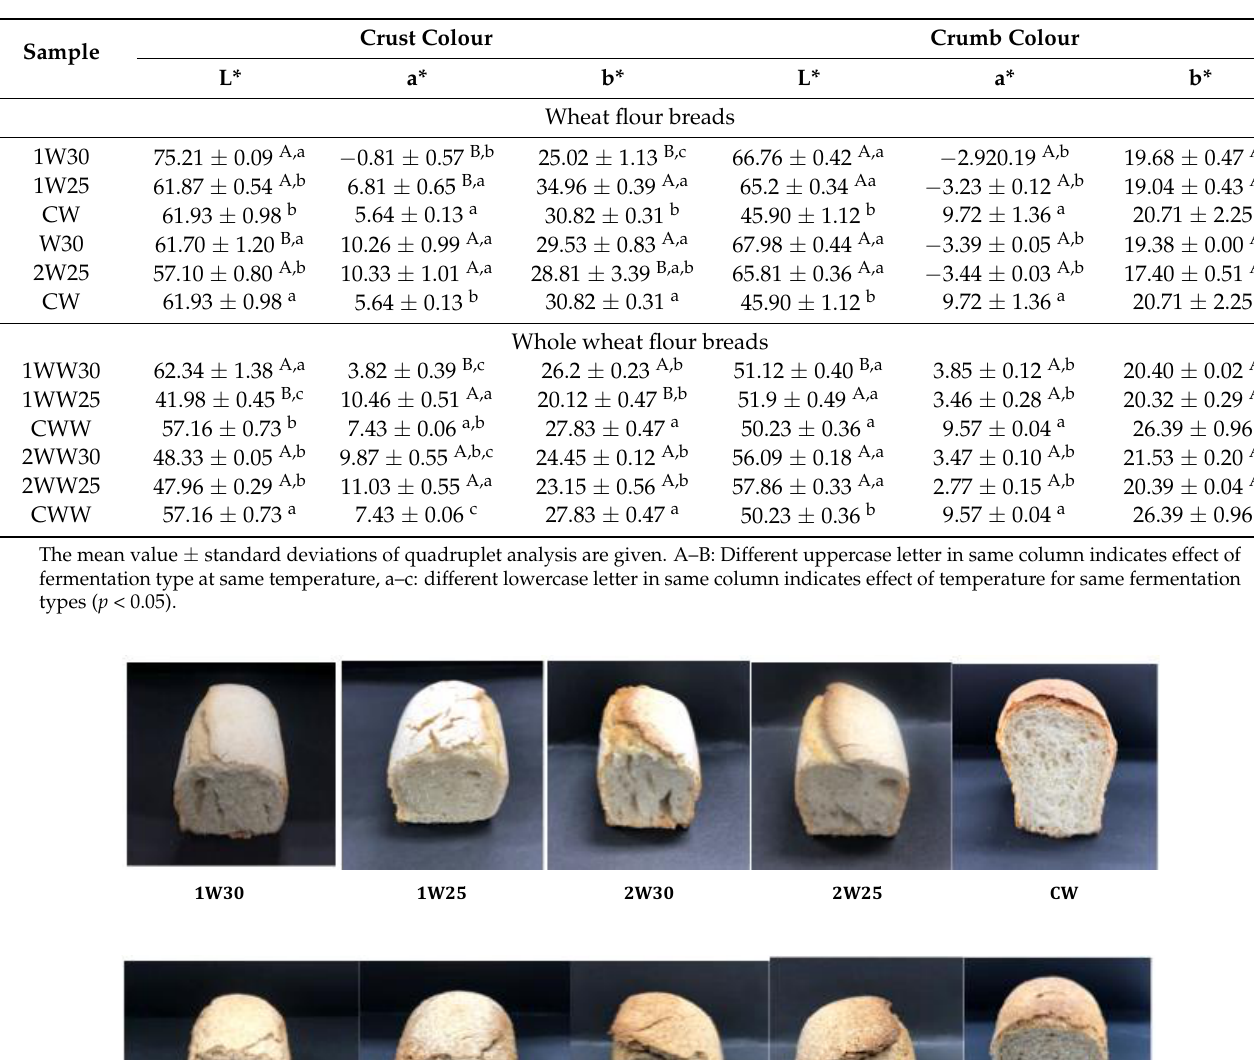
Table 4. Color properties of the breads.